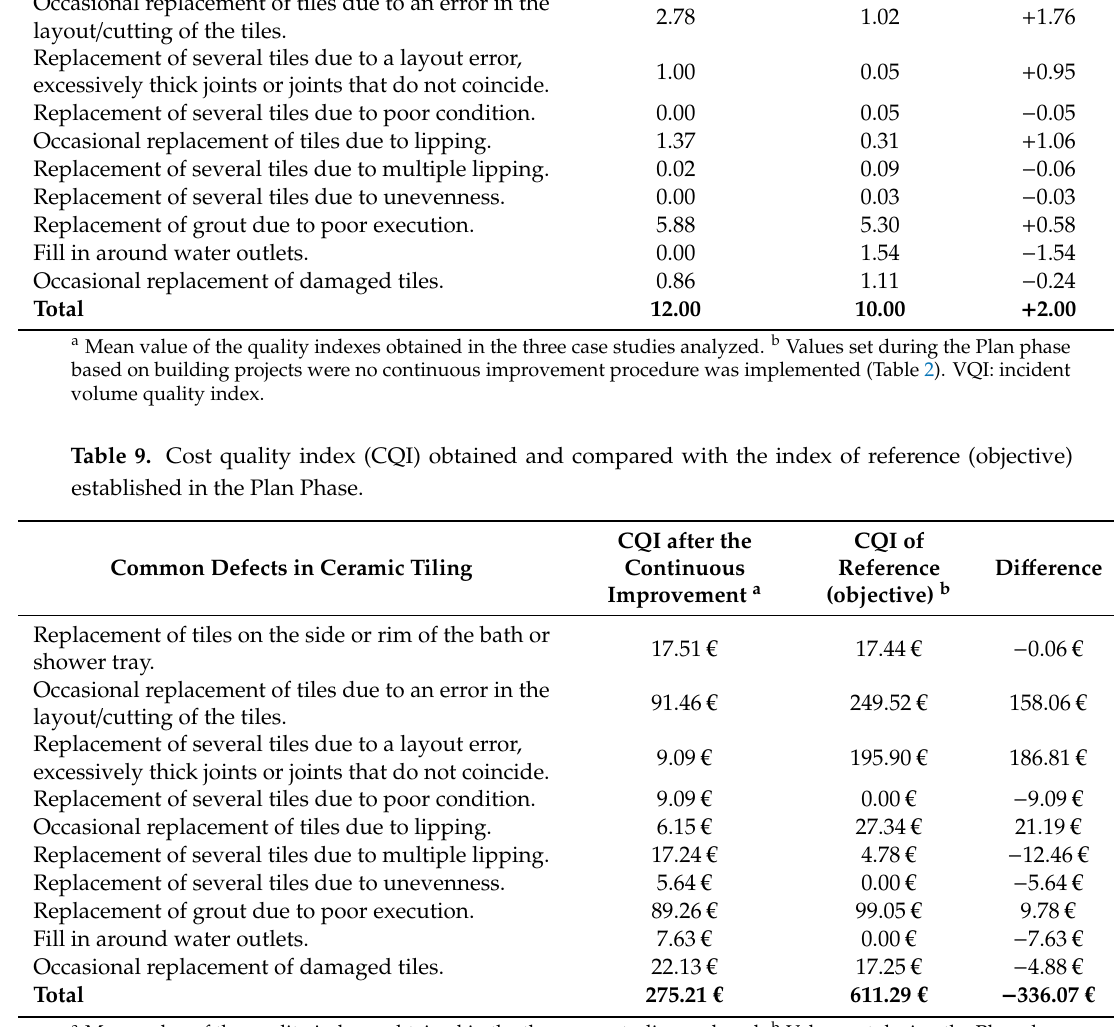
VQI of VQI after the Reference Di ff erence Continuous (Objective) b Improvement a 0.15 0.16 − 0.02 2.78